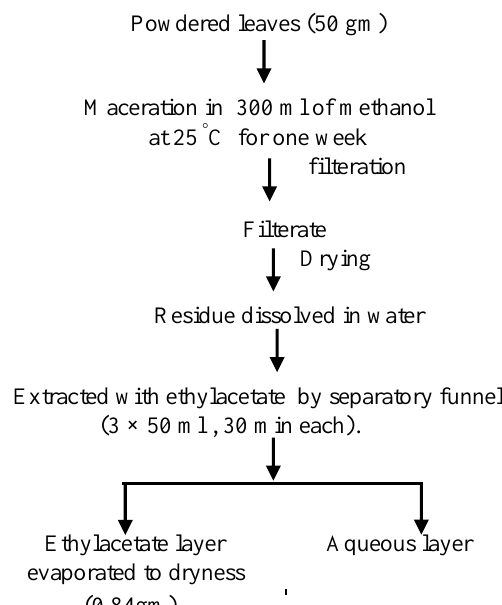
Figuer (2 ): General scheme for method No.1 for extraction of steroidal sapogenins from the leaves of Agave americana